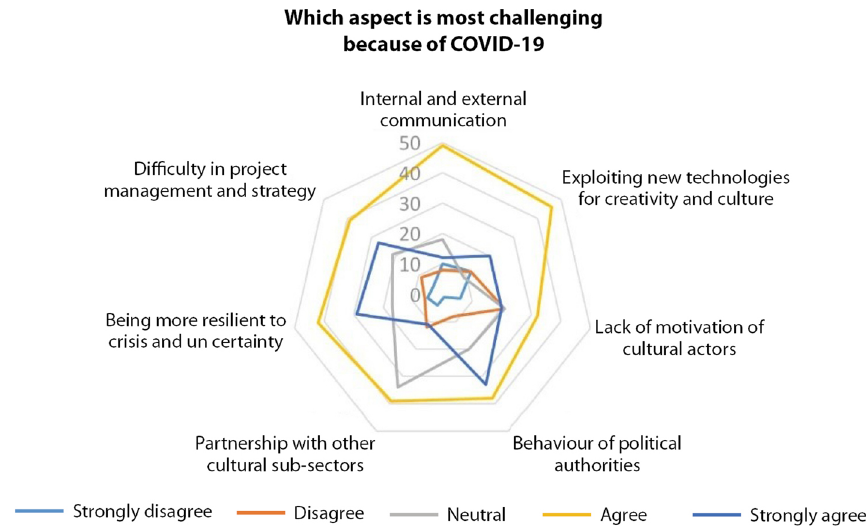
Fig. 14 challenging aspects because of COVID-19 (Source: the authors)